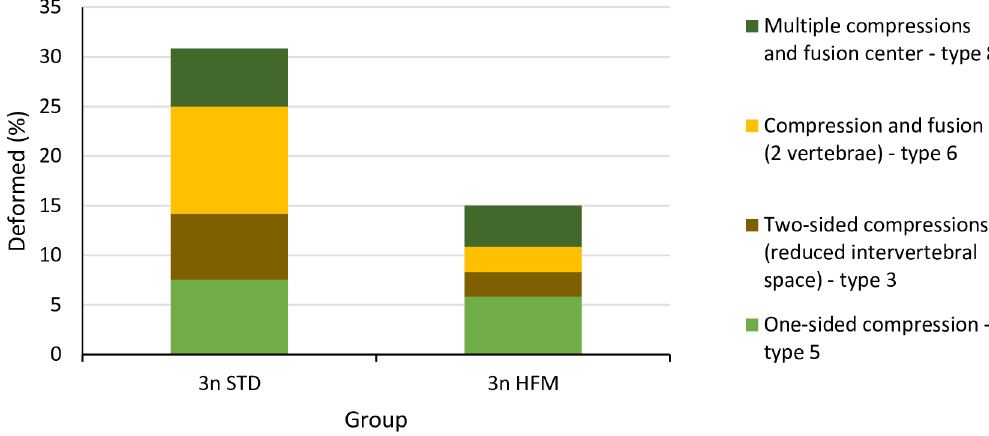
Fig 7. Types of vertebral deformities observed in triploid salmon smolt. Mean prevalence of vertebral deformity types in triploid (3n) Atlantic salmon, Salmo salar , smolt (2745 ddPSF) fed fish meal (STD) and hydrolyzed fish protein (HFM) diets. Classification of vertebral deformities according to Witten et al.